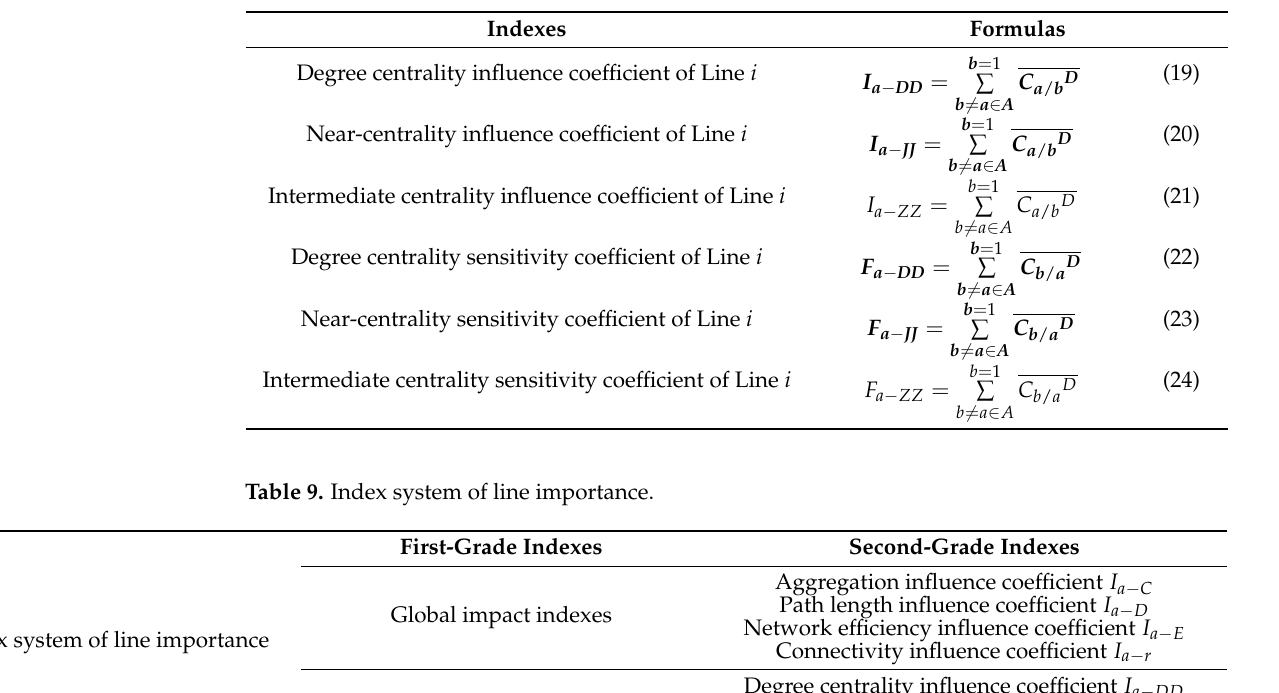
Table 8. Central influence coefficient.